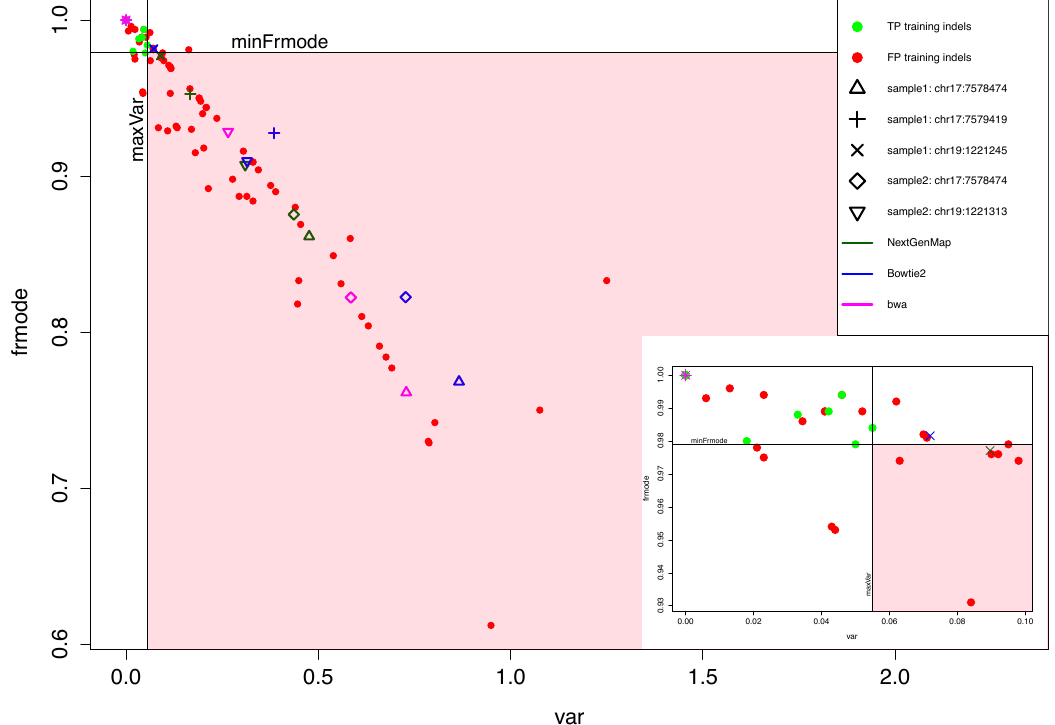
Figure 2. Distribution of the variance of the gap/insert length ( var ) and frequency of the most common gap/insert length ( frmode ) at the potential indel site. Green circles represent values for the parameters var and frmode for 18 true positive (TP) training indels, and red circles represent var and frmode for 90 false positive (FP) training indels. We used training indels to define threshold values for filtering parameters var and frmode . maxVar is the maximum value among all var values for training TPs. minFrmode is the minimum frmode among all frmode values for training TPs. We filtered out a potential indel x if var (x) > maxVar and frmode (x) < minFrmode (red shaded area). In this way, we detected all training TPs and filtered out 60% of the training FPs. To test the parameter filtering settings, we used five test indels coming from two samples (S 1 and S 2 ) which Sanger sequencing showed to be FPs. Parameters for each test indel are presented by a combination of a symbol (indel genomic position) and a color (aligner), e.g., the “+” magenta symbol represents var and frmode for an indel at the position chr17:7579419, for which the parameters were calculated from the bwa aligned file. Since the parameters were calculated for at least one aligner are in the area from which the indels were filtered out, we filtered out all five FP test indels. A small plot in the right bottom corner of the figure is an enlargement of the left upper corner of the main